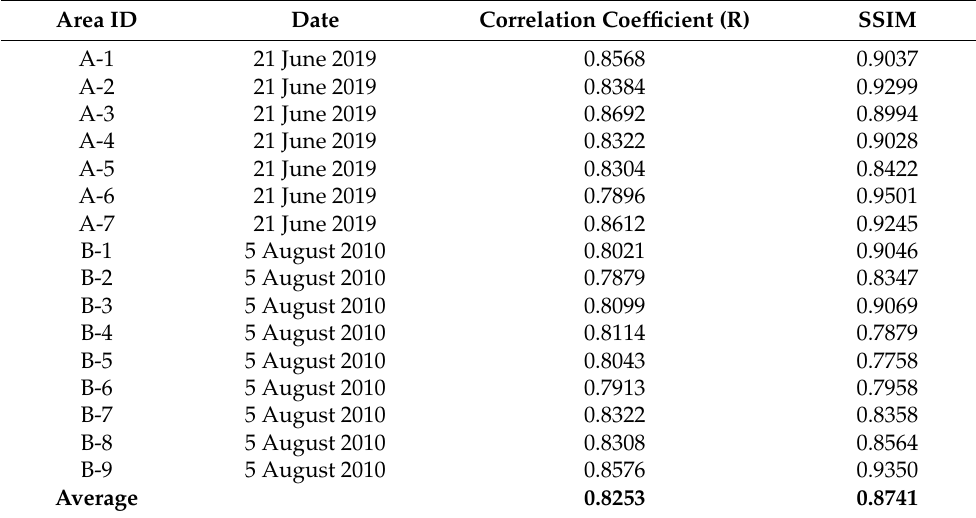
Table 1. Comparisons between the PlanetScope images (resampled to 30 m) and QTP-NDVI30- based images at two test sites. Seven and nine PlanetScope images were available for sites A and B (Figure 1B),